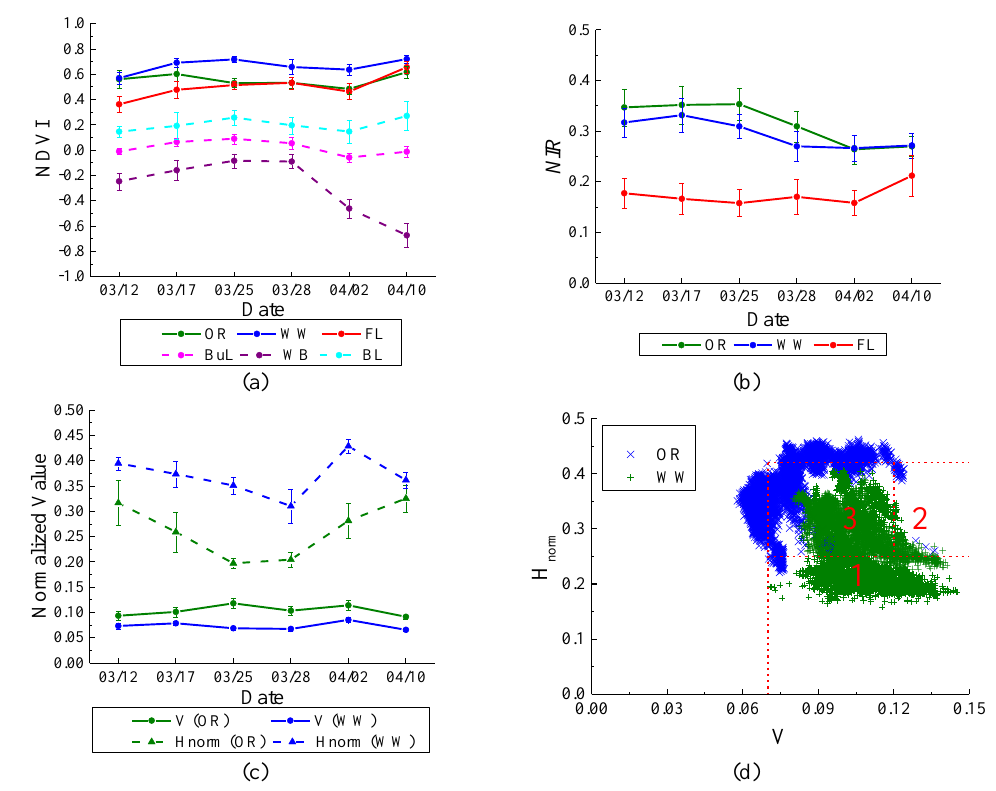
Figure 4. The multi-temporal ( a ) NDVI of each land cover type; ( b ) reflectance at near-infrared band of vegetation types; and ( c ) H norm and V values of crop types for the training samples of Wuxue City. ( d ) Three H norm -V spaces separate OR and WW. 03/12, 03/17, 03/25, 03/28, 04/02, and 04/10 are the abbreviations of 12 March 2015, 17 March 2014, 25 March 2015, 28 March 2016, 2 April 2014, and 10 April 2014, respectively. FL, BuL, WB, and BL in the legends mean forest land, built-up land, water body, and bare land, respectively.